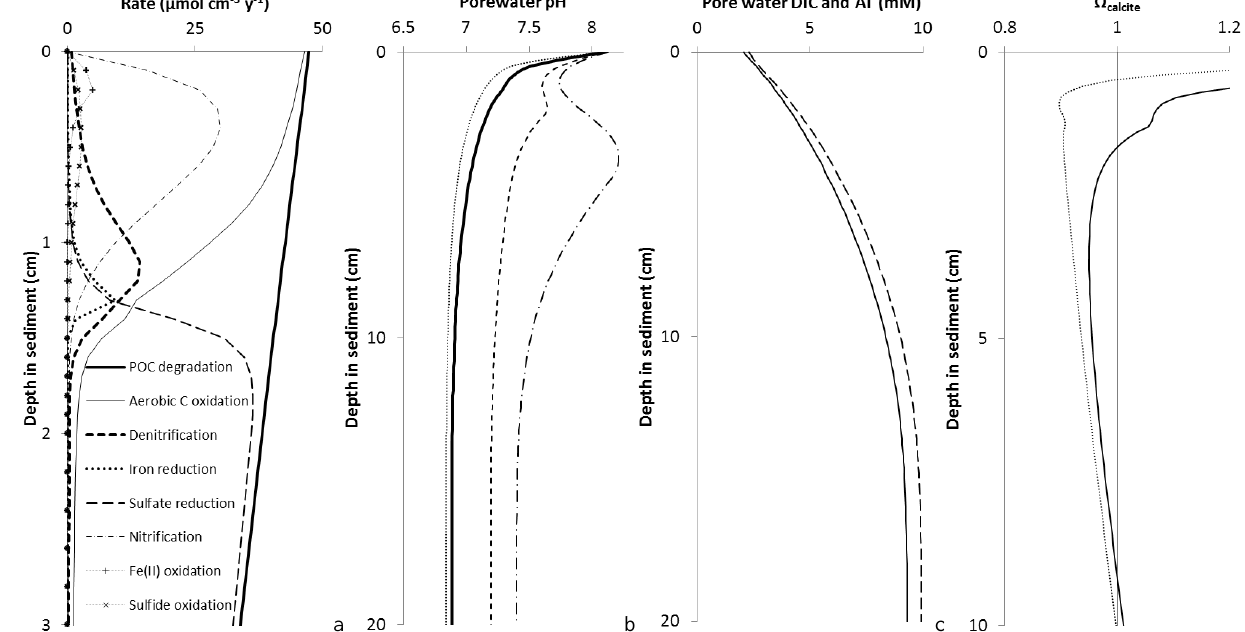
Fig. 1. (a) Redox reactions depth profiles, 75m carbonate shelf, baseline POC flux. Total POC oxidation ( — ), aerobic C oxidation (—), denitrification ( --- ), iron reduction ( ..... ), sulfate reduction (---), nitrification (– · – · ), Fe(II) oxidation ( + ), and sulfide oxidation (